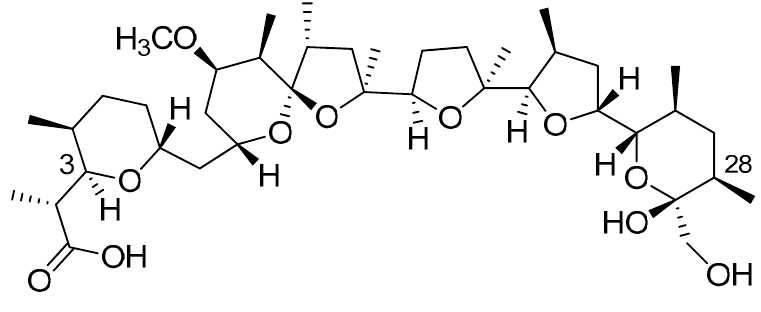
Figure 1. Molecular structure of nigericin.